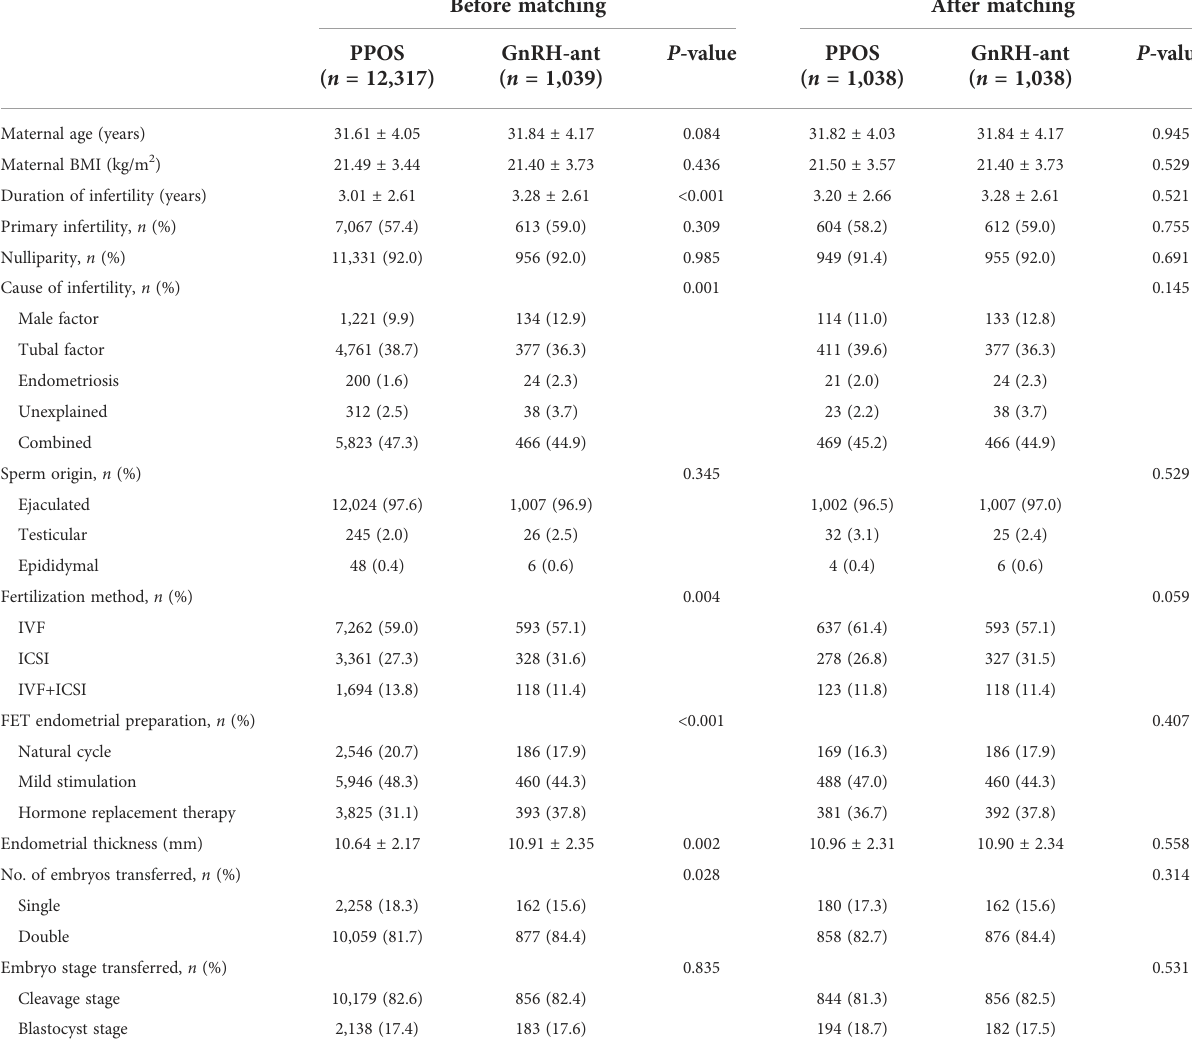
TABLE 1 Maternal and cyclic characteristics of the live birth cycles between the PPOS and GnRH-ant groups. Before matching After